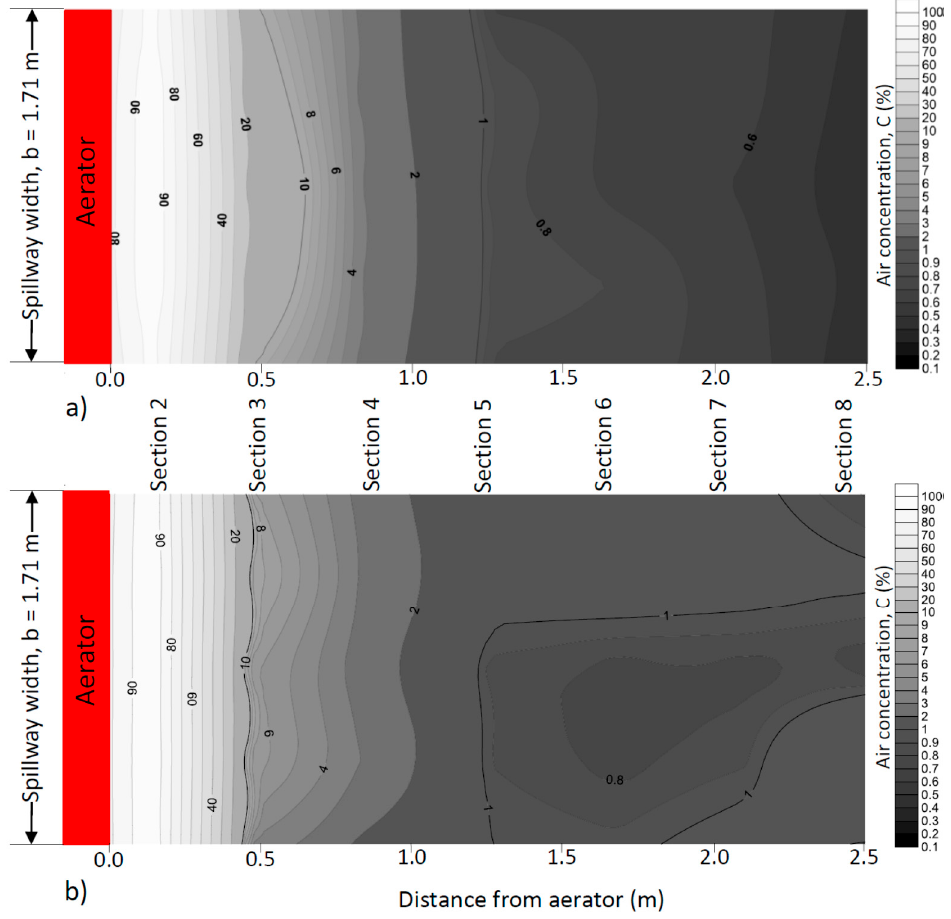
Figure 10. Bottom air concentration distribution for Q = 1000 L/s ( a ) spillway without pier, ( b ) spillway with pier.